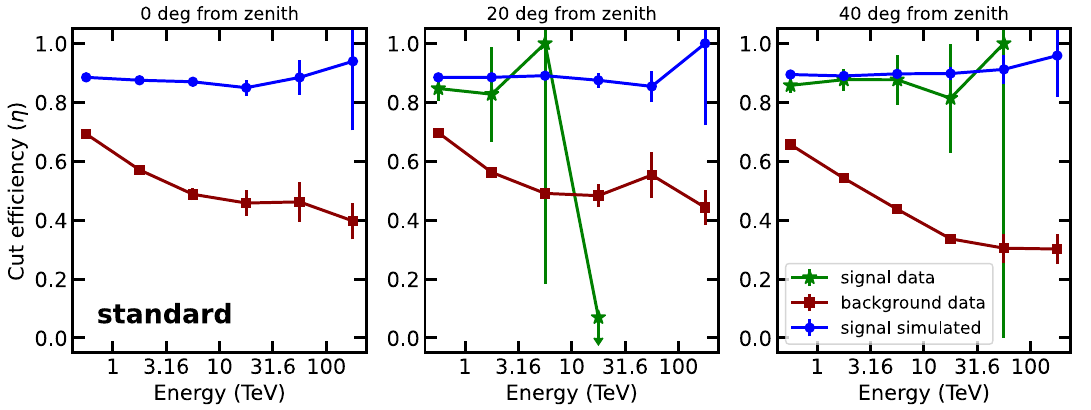
Fig. 3 Fraction of events kept by the ABRIR cut applied after the H.E.S.S. standard cuts for simulated gamma-rays (blue dots), back- ground data from off-runs (red squares) and events taken from a radius of 0.2 ◦ from bright gamma-ray sources (green stars), in particular the blazar PKS 2155-304 at zenith angles of 20 ◦ and the Crab Nebula for